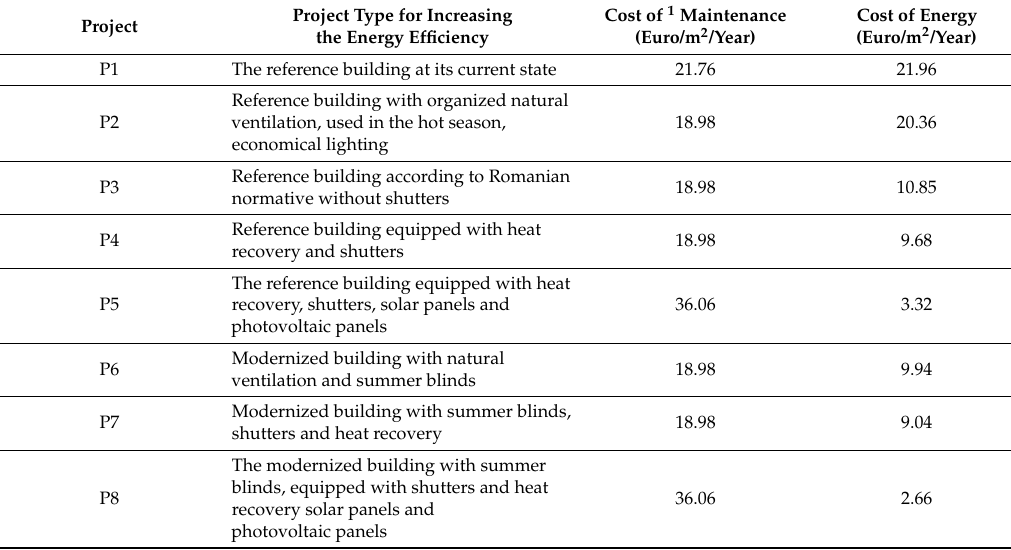
Table 3. Operating costs of the reference building following the implementation of the energy efficiency improvement projects.